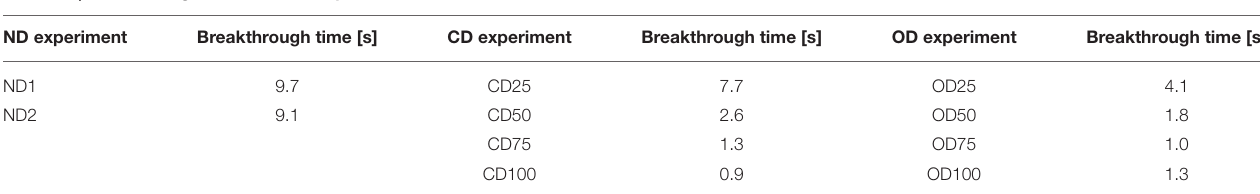
TABLE 1 | Breakthrough times for the